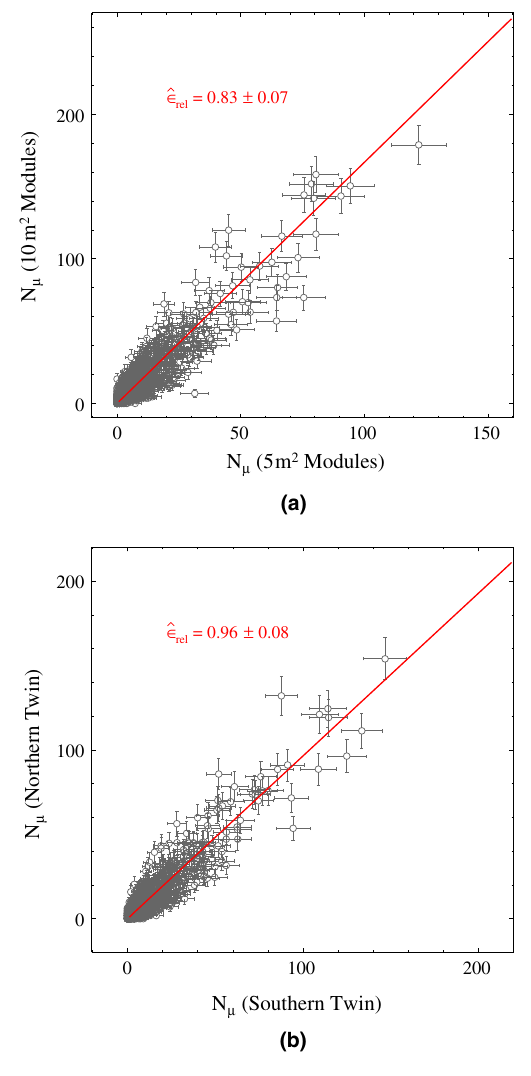
Fig. 6 Relative efficiency from EAS data in twin detectors. a Between detectors of different areas (10m 2 with respect to 5m 2 modules). b Betweenidenticaldetectorareasof30m 2 .Theestimationoftherelative efficiency is obtained from Eq. (5), and its value is used for plotting the red solid